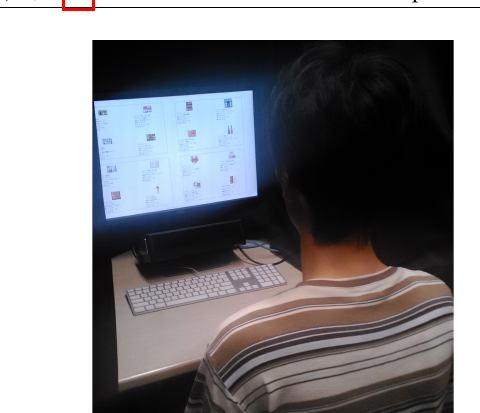
Figure 1 . Experimental environment. A participant is brows- ing a digital catalog on a display. Gaze data of the participant are recorded by the eye tracker installed below the display.